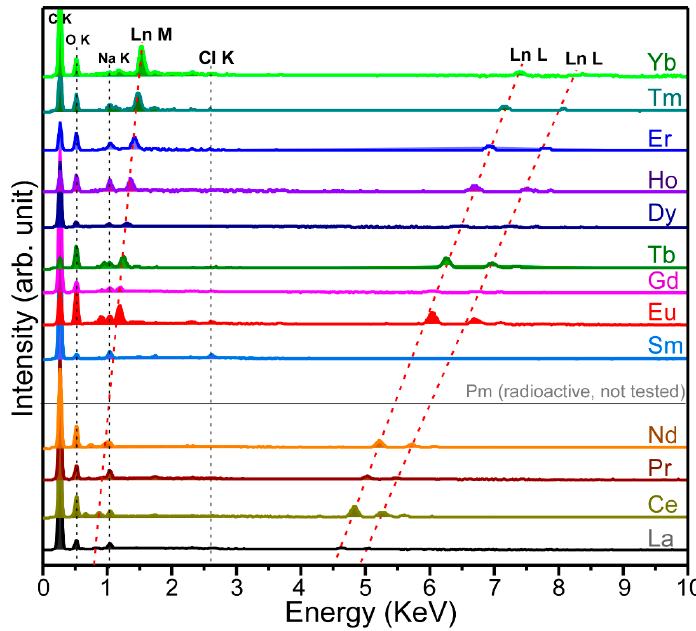
Figure 3. EDXS profiles for electrodeposited Ln elements on carbon sheets.